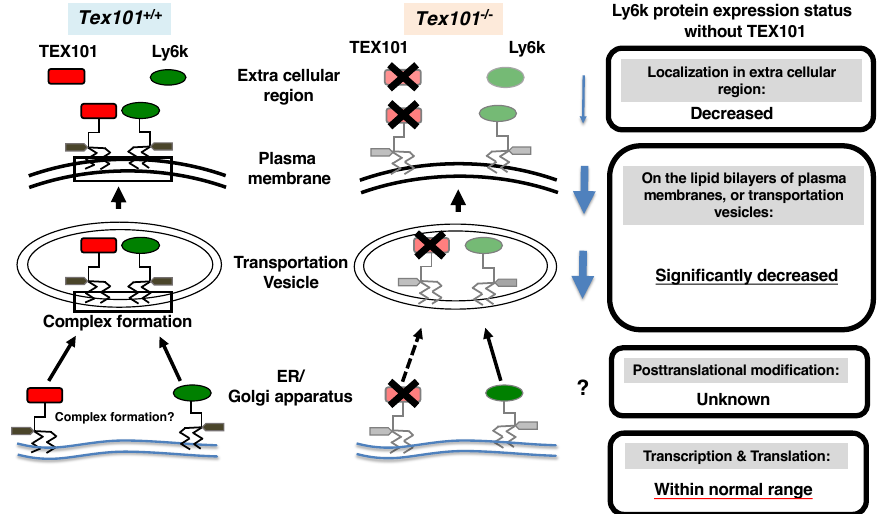
Figure 3. Molecular status of Ly6k with / without TEX101 in the testicular germ cells (TGCs) . The left diagram indicates TEX101 / Ly6k complex formation of wild-type (Tex101 +/+ ) mouse. After